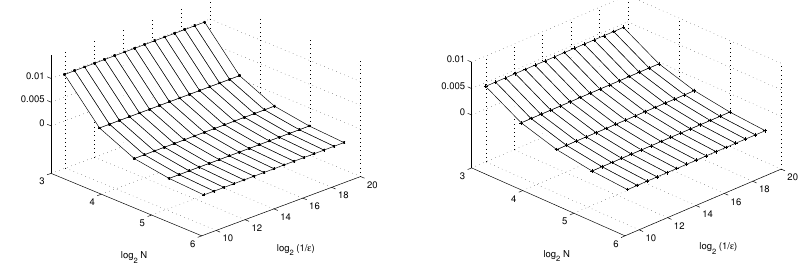
Figure 6. Surface plot of the maximum pointwise errors as a function of N and ε for the solution components Y 1 and Y 2 using HDS - II for the Example 2.